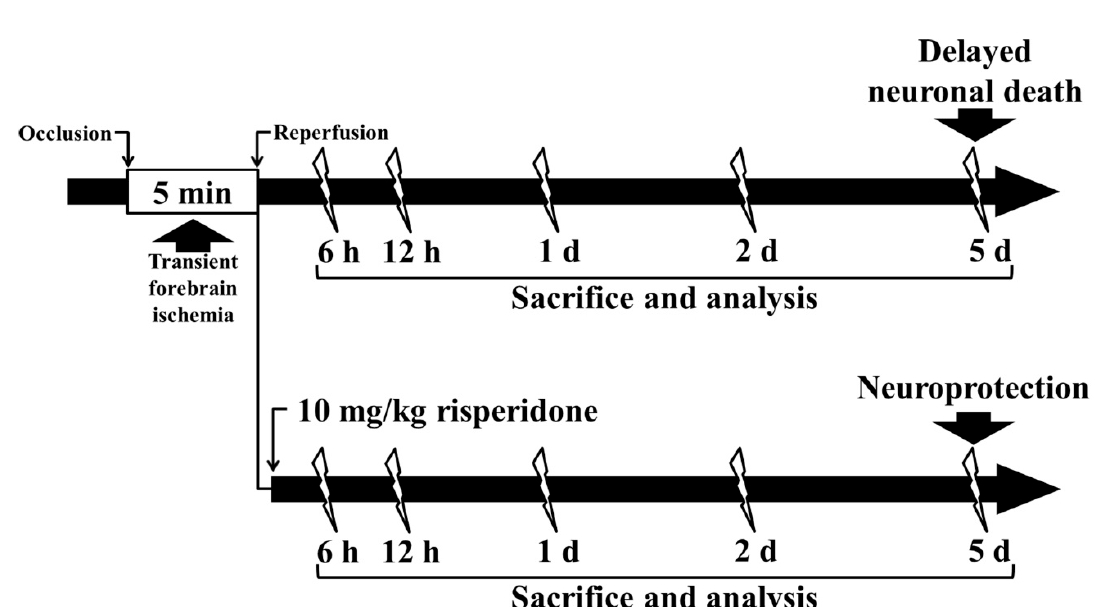
Figure 9. Experimental timeline. The gerbils underwent 5-min tFI. They were sacrificed at 6 h, 12 h, 1 d, 2 d, and 5 d after tFI, and their hippocampi were analyzed using immunohistochemistry and Western blot analysis. The gerbils post-treated with 10 mg/kg RIS were sacrificed at 6 h, 12 h, 1 d, 2 d, and 5 d, and their hippocampi were analyzed by immunohistochemical staining.